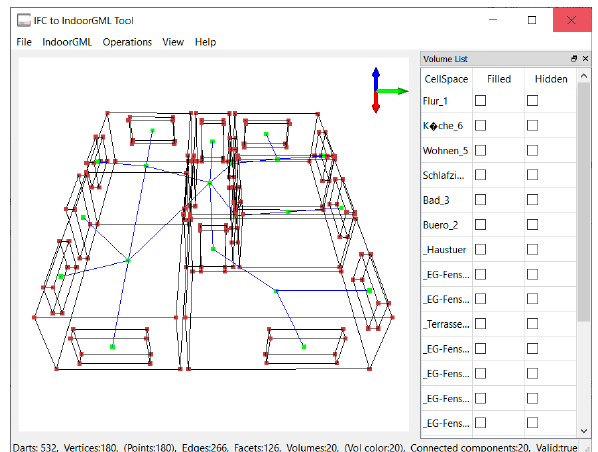
Figure 8. User interface of the ifc2indoorgml tool, with a model loaded in the